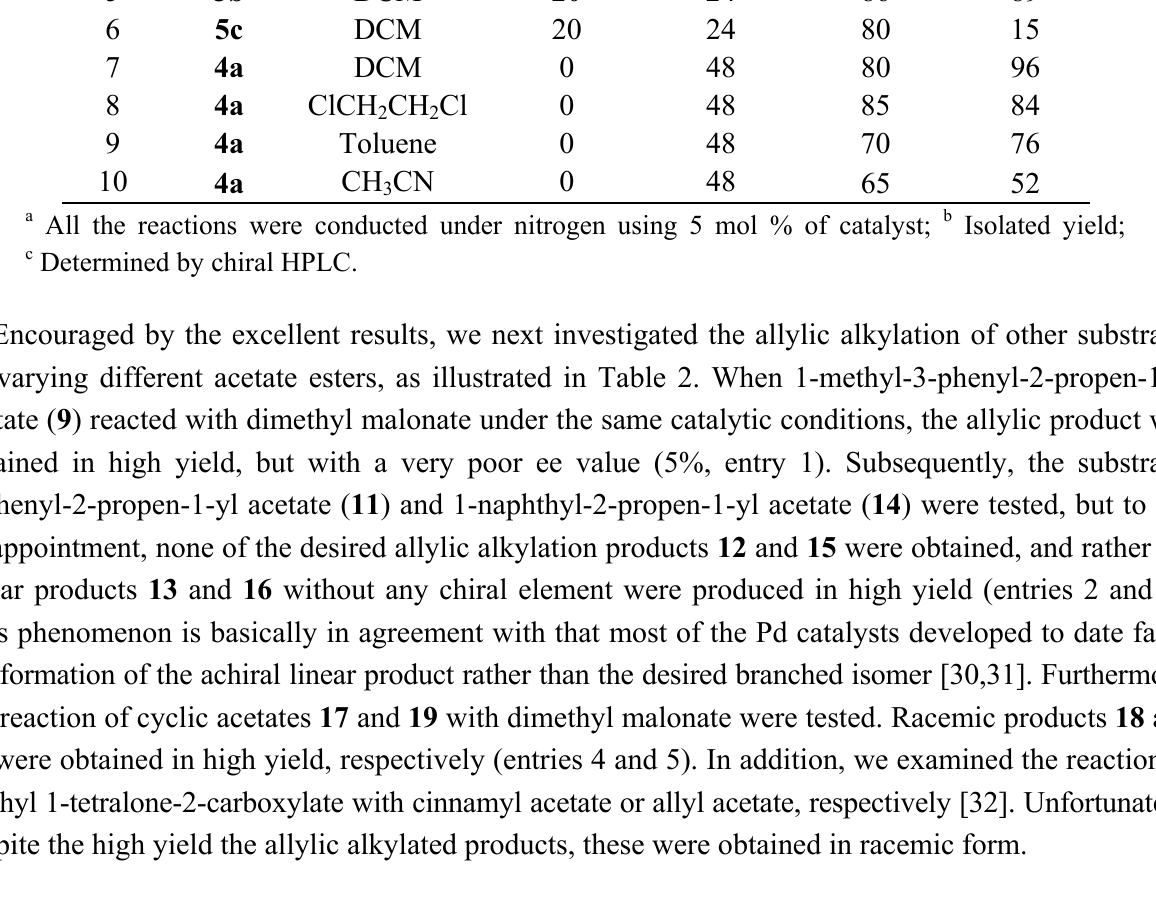
Table 2. Palladium-4a complex catalyzed allylic alkylation of various substrates a